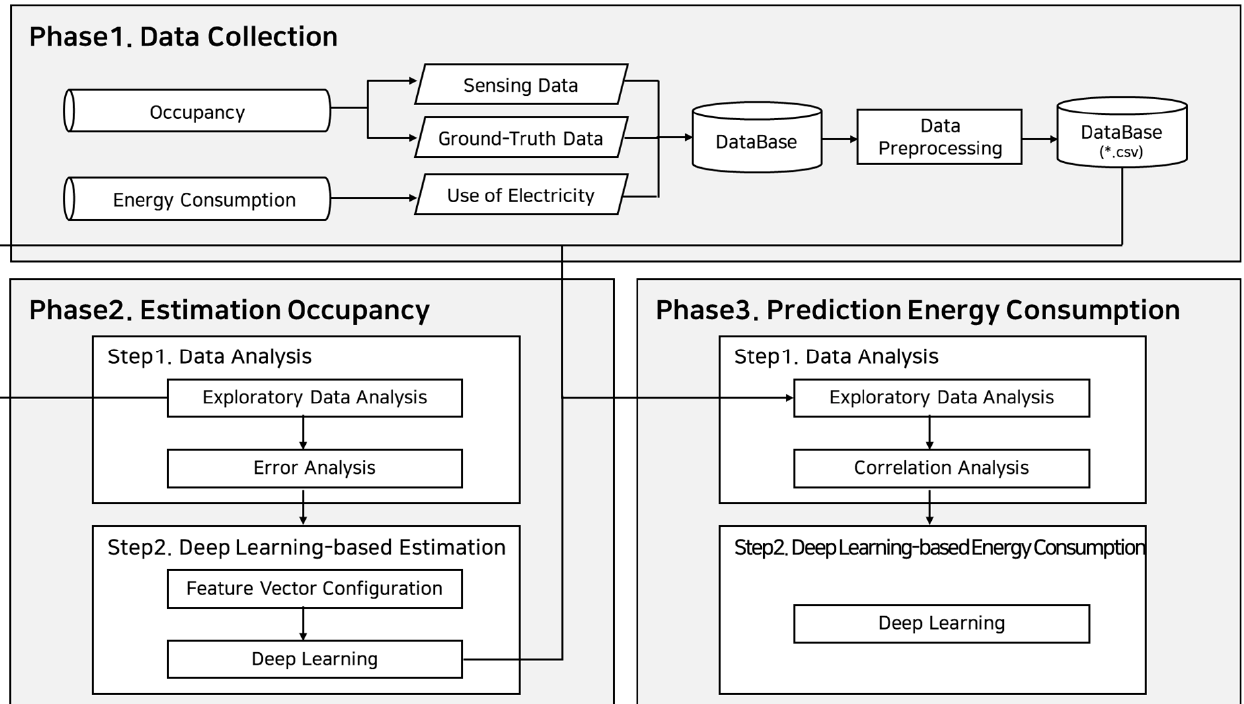
Figure 1. Methodology for estimating occupancy and predicting energy consumption using deep learning.